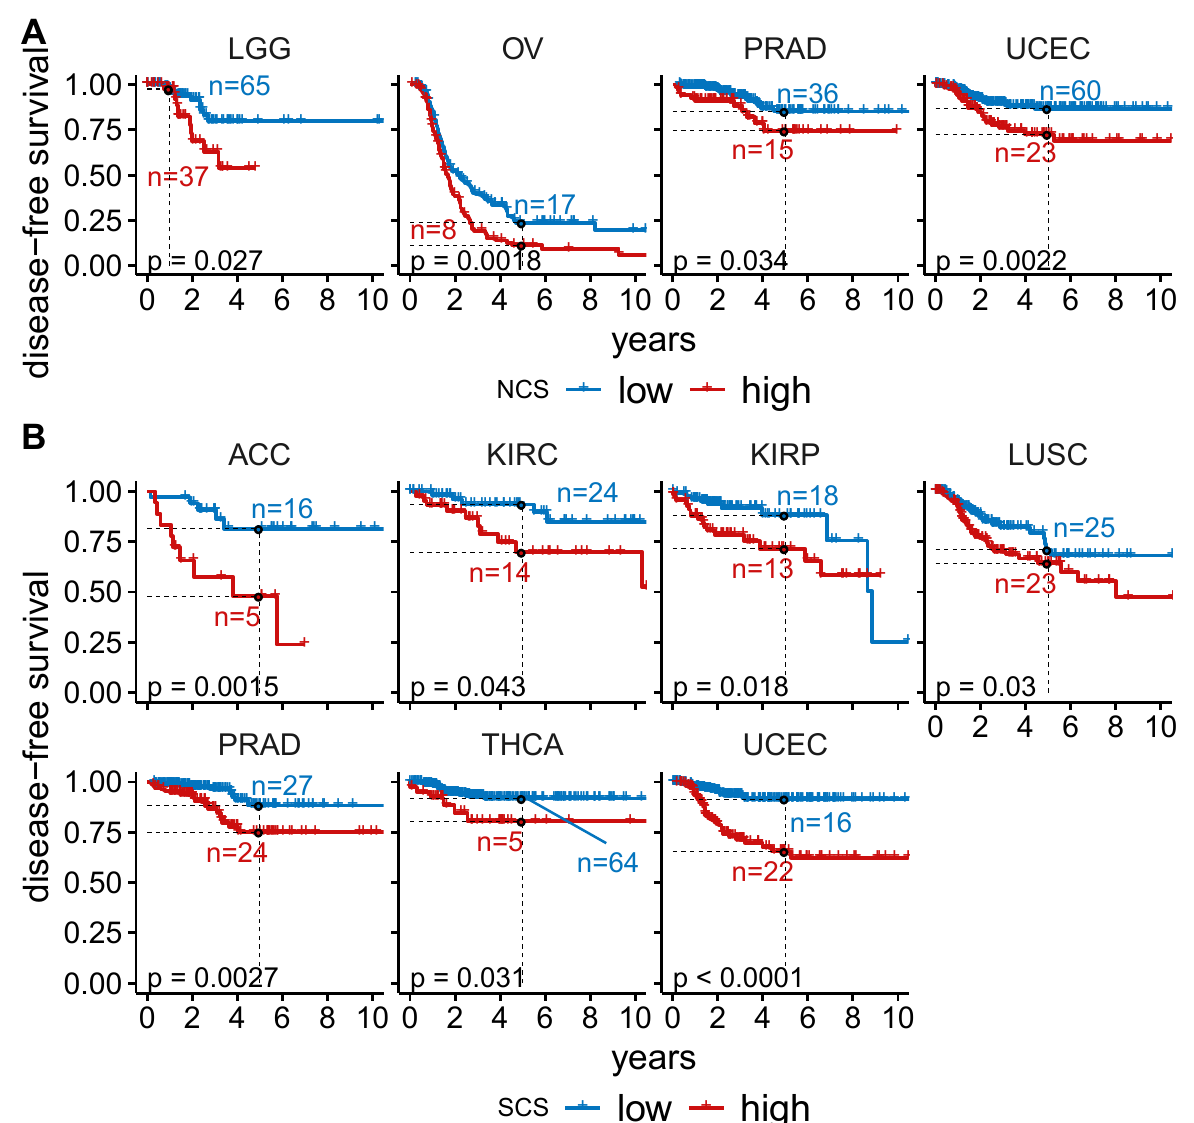
Figure A3. ( A ) Disease-free survival in four cancer types where significant differences between high- and low-NCS groups were observed. ( B ) Disease-free survival in seven cancer types where significant differences between high- and low-SCS group were